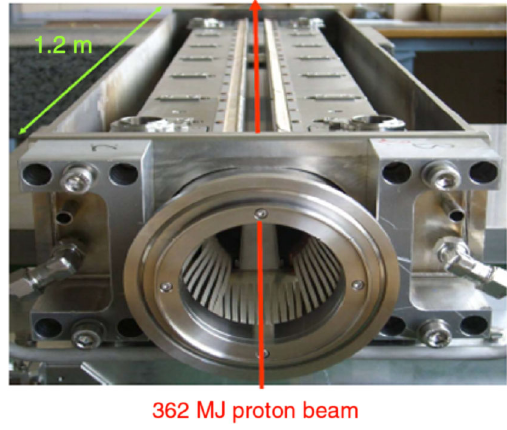
FIG. 1. A horizontal LHC collimator. View into the open vacuum tank of the collimator during production. The beam trajectory is shown in red, with the left and right jaw assemblies centered with respect to the closed beam orbit. The jaws lie inside the casing, on either side of the beam, with the radio-frequency fingers showing in the foreground